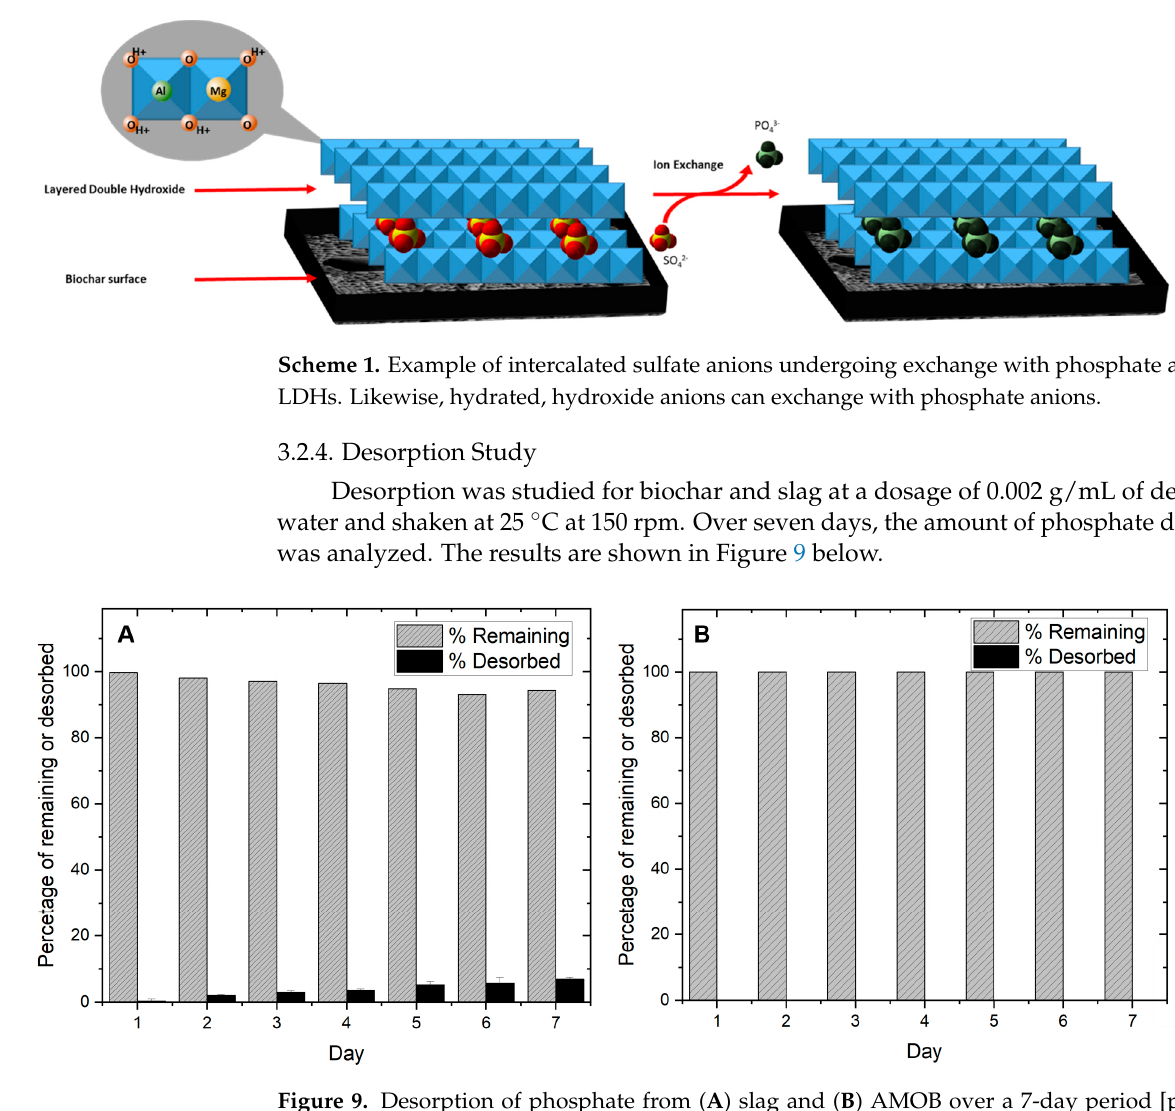
Figure 9. Desorption of phosphate from ( A ) slag and ( B ) AMOB over a 7-day period [pH = 5.0; adsorbent concentration = 0.002 g/mL].